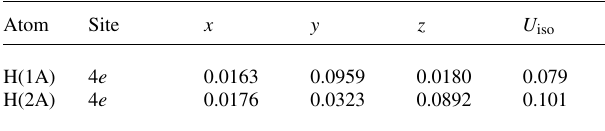
Table 2. Atomic coordinates and displacement parameters (in Å 2 )